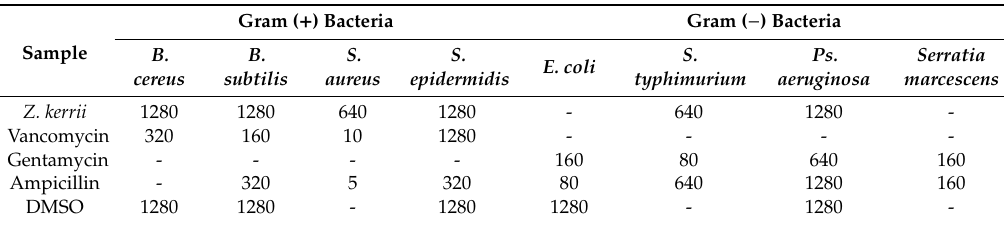
Table 4. Antibacterial activity of Z. kerrii rhizome